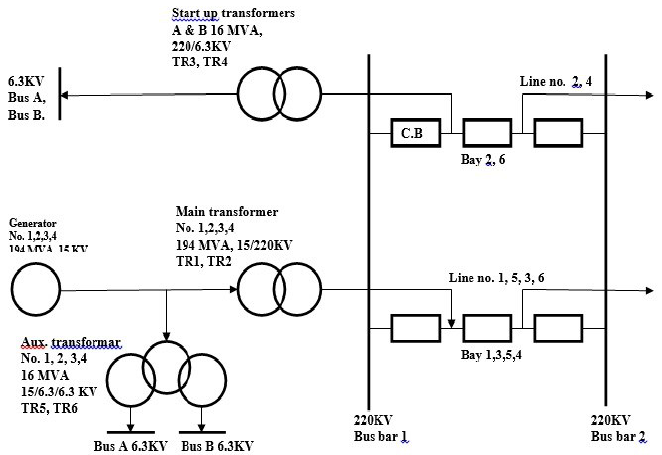
Fig. 2. Schematic Diagram for